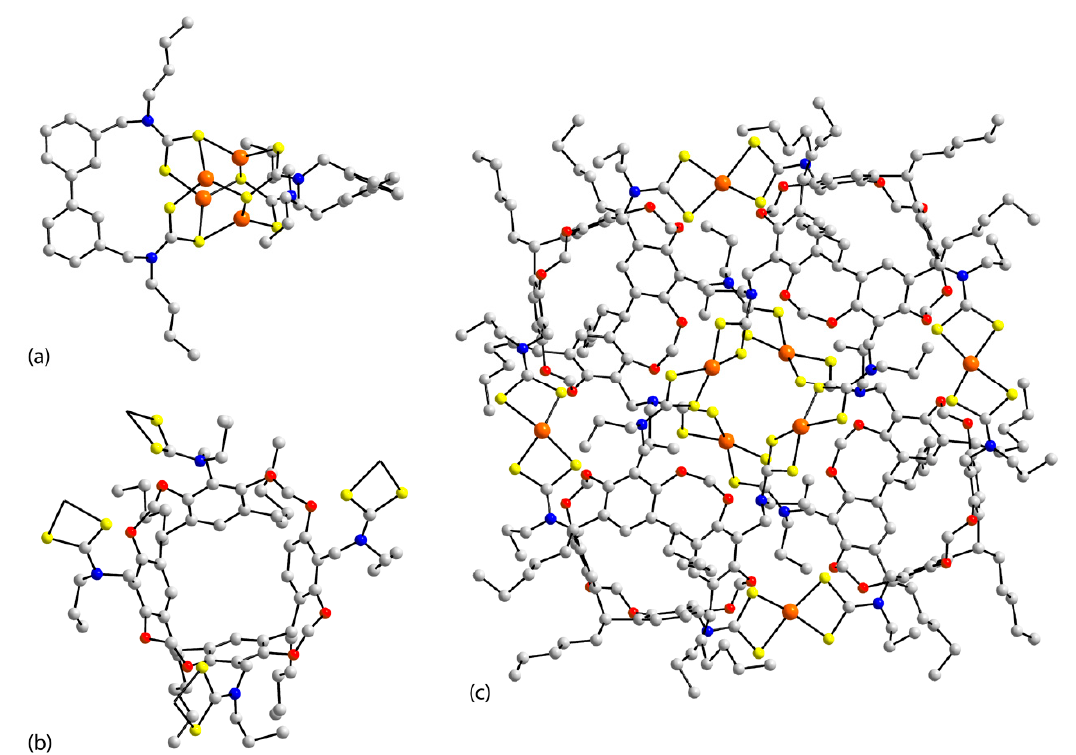
Figure 6. ( a ) Molecular structure of tetra-nuclear Cu 2 (L 10 ) 2 in 26 , ( b ) detail of the tetradentate mode of coordination of the L 11 di-anion in [Cu 8 (L 11 ) 4 ] 8+ in 27 and ( c ) molecular structure of octa-nuclear [Cu 8 (L 11 ) 4 ] 8+ in 27 .